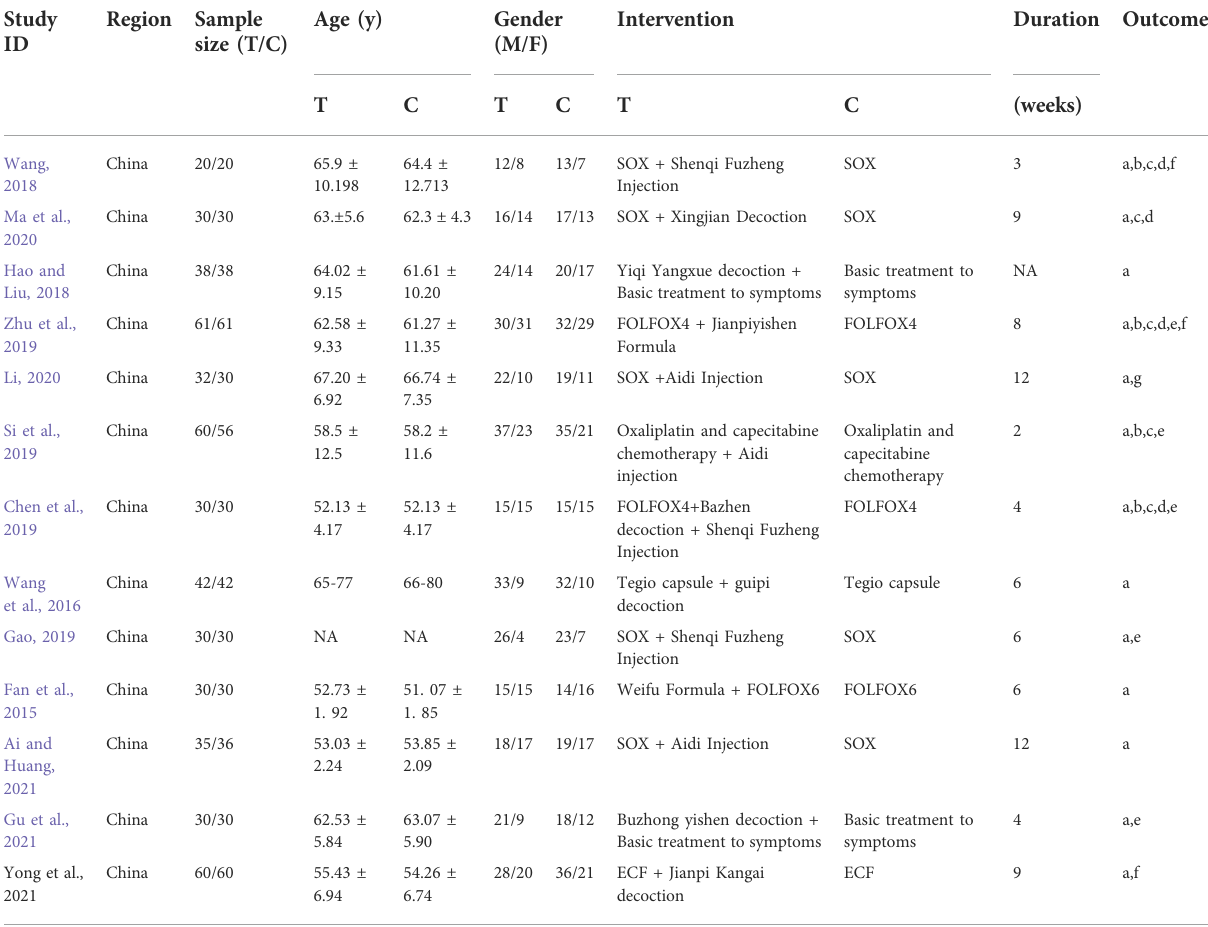
TABLE 1 Characteristics of RCTs included in the